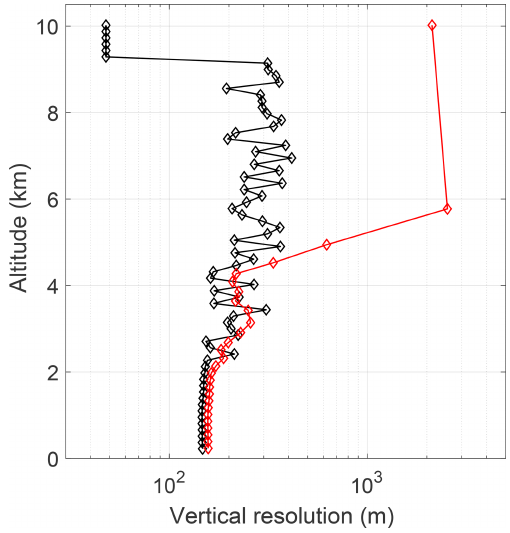
Figure 4. The vertical resolution profile on 22 January 2013 12:00UT. The vertical resolution will decrease on the coarse grid as the points are used to reach one degree of freedom. The last two points have vertical resolutions of several hundred meters but are not considered meaningful points as they have total uncertainties larger than